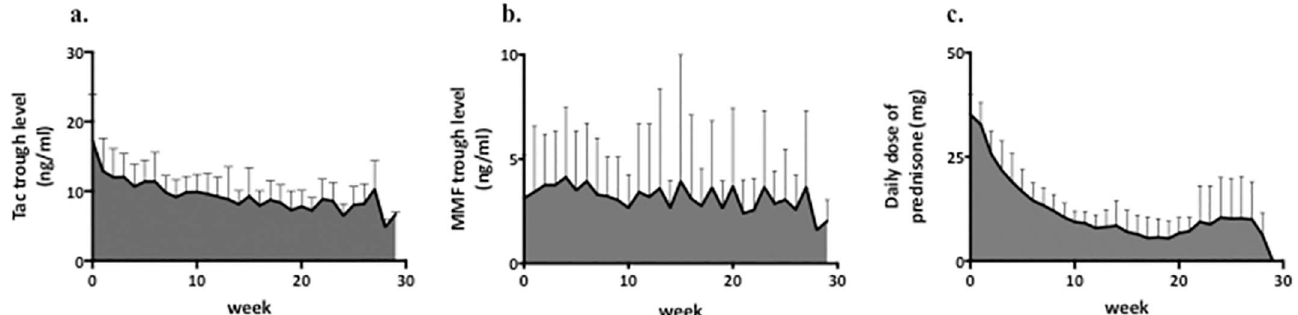
Fig 2. a, b, c Area under the curve of tacrolimus, MMF and prednisone over the study period from t 0 to t 6